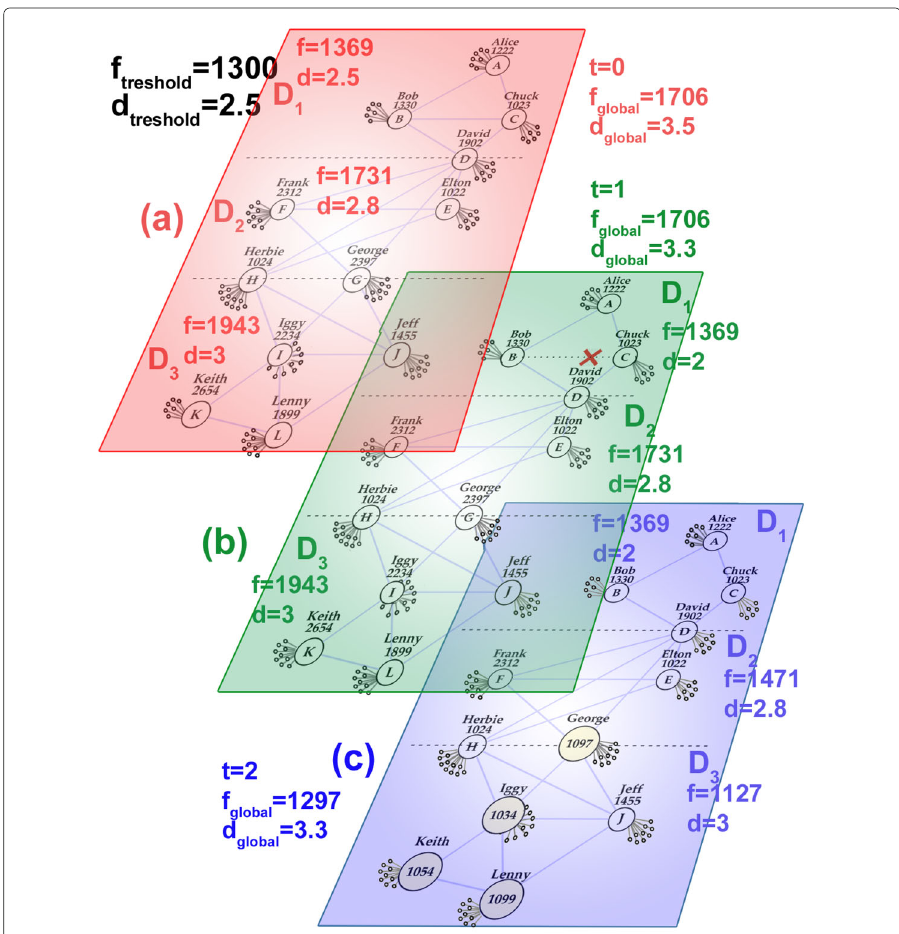
Fig. 3 A local breach affect in a real-time smart city OSN application. The graph reviews real- time influential rock-stars events, distributed to three graph datasets (geographic regions) denoted by D 1 , D 2 and D 3 . The graphs edges are friendships among events participators, and we focus on the numeric attribute of average number of participators of each event, as well as the users average number of inner-community friendships (the vertices degrees). a We define entry-level conditions of 1000 followers per user, and at least 2 inner-community friendships. The global threshold T is defined by the average of 1300 followers per user and an average of 2.5 inner-community friendships. The change in the graph after time goes by as can be seen in ( b , c ). b describes D at t = 1 min . A change occurred in this time space ( 0 − 1 ) , and Bob un-friended Chuck, changing the local average degree in D 1 from 2.5 to 2 which broke the local threshold of 2.5. This change did not break T since the total average degree is still bigger than 2.5 (it changed from 3.5 to 3.33), thus the global community-defining conditions remained valid. c describes D at t = 2 min . Several changes occurred in this time space (1-2), and the number of followers of the rock stars in D 3 was reduces by 4900, changing the local average of followers from 1943.8 to 1127.2. This change broke T since the total average of followers is less than 1300 (1297.8), thus the community broke its defining